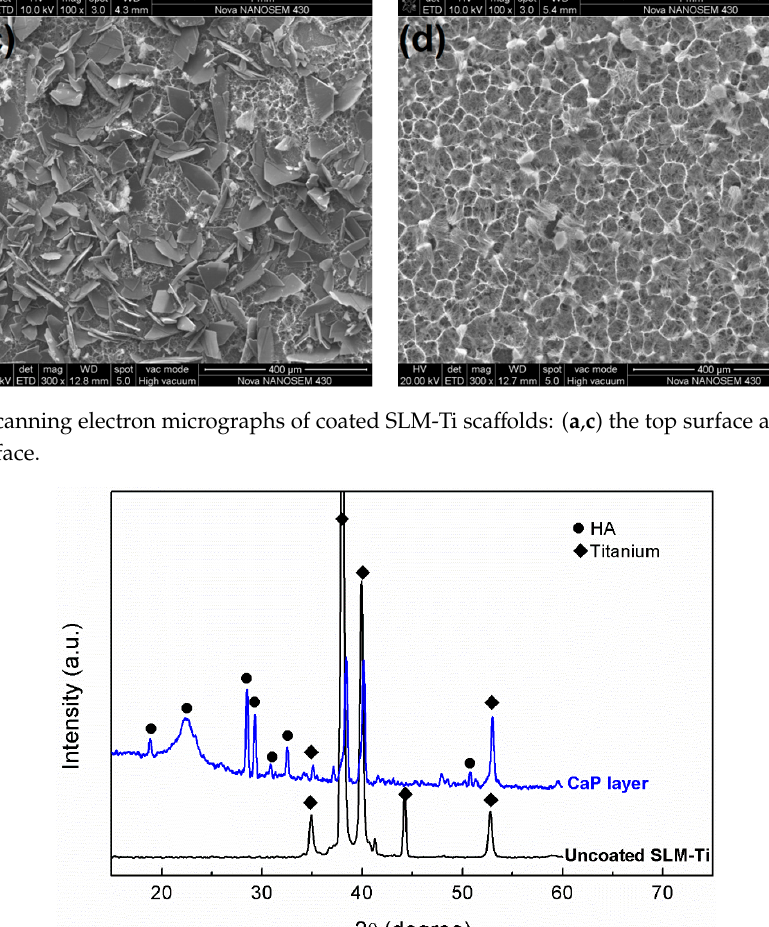
Figure 4. XRD analysis of the crystalline structure of deposited layers on SLM-Ti scaffolds.